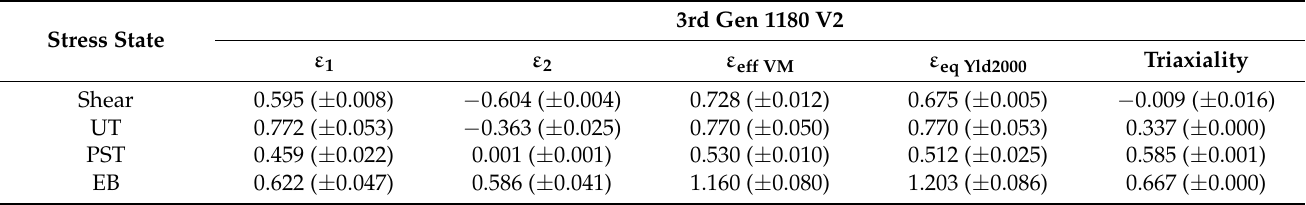
Table A8. Summary of fracture strains for the 3rd Gen 1180 V2 AHSS. Note that the von Mises effective strain corresponds to the absolute strain assuming a linear strain path. The Barlat Yld2000 equivalent strain corresponds to the accumulated work-conjugate equivalent strain integrated along the measured strain path and accounts for material anisotropy. Stress